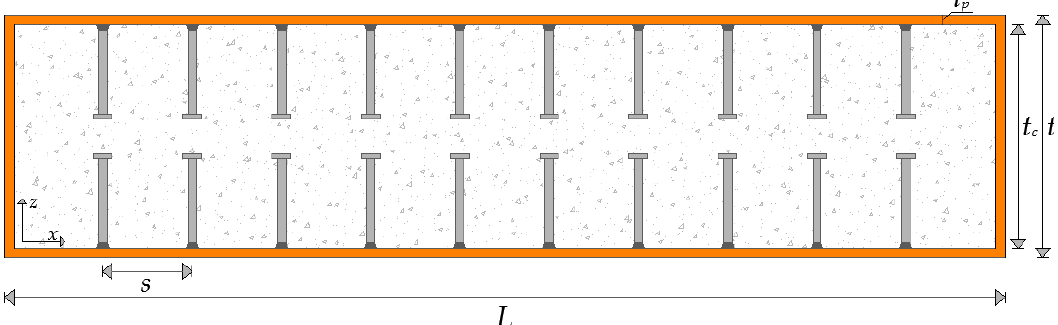
Figure 1. Cross-section of a double-steel plate concrete wall with confined concrete.